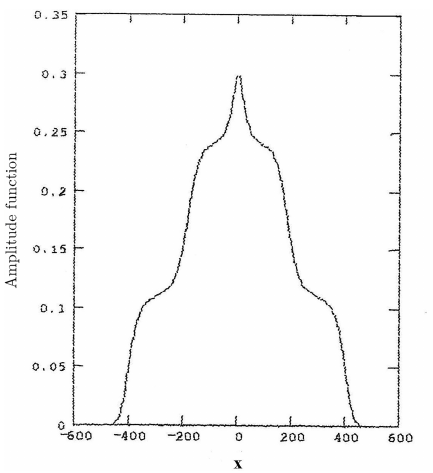
Figure 4. Amplitude function for the three-humped solitary wave.